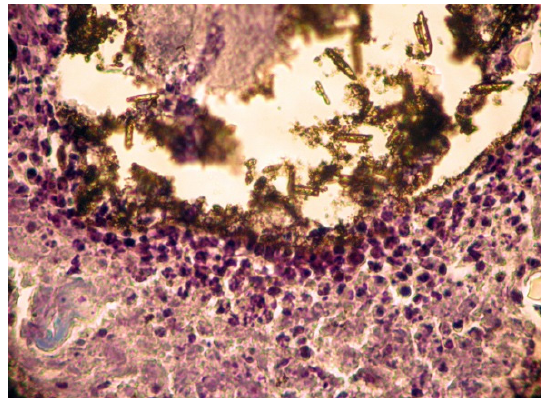
Figure 4. Group A. Subcutaneous conjunctive tissue. Area of necrosis, intense leukocyte infiltration.